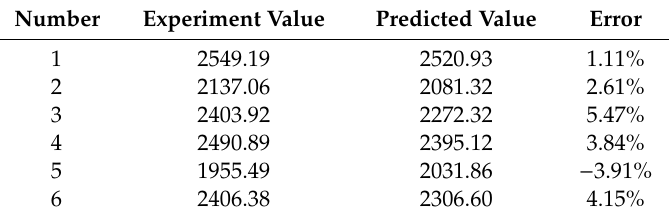
Table 15. Comparison of experimental values and predicted ones of diesel engine torque ( Nm )